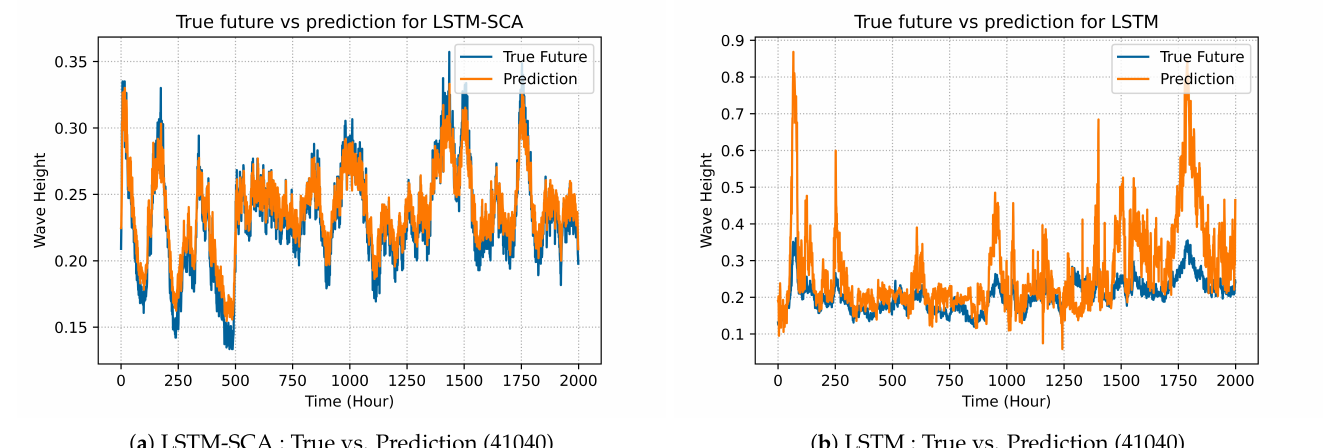
Figure 6. Comparsion of VRNN models on dataset 41040.